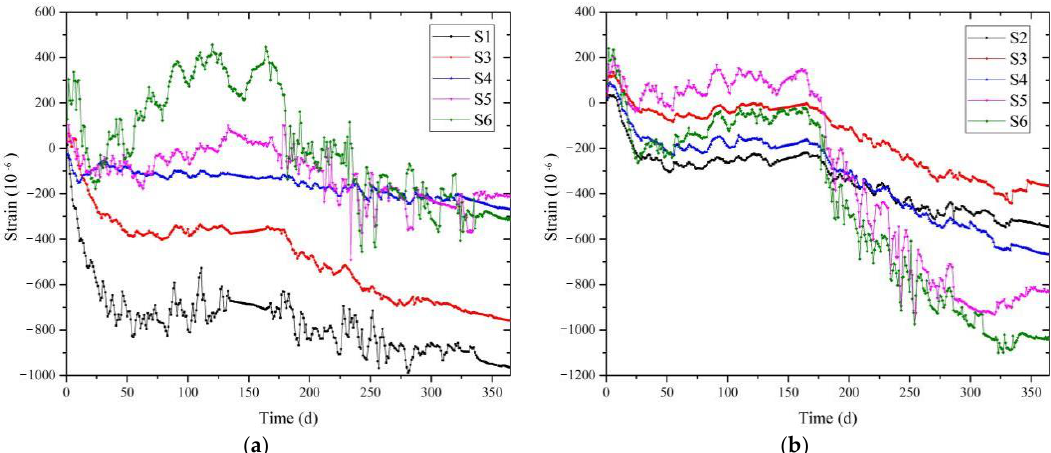
Figure 10. Strain curve of wall panels: ( a ) Strain curve of GRC layer for each panel; ( b ) strain curve of PC layer for each panel.